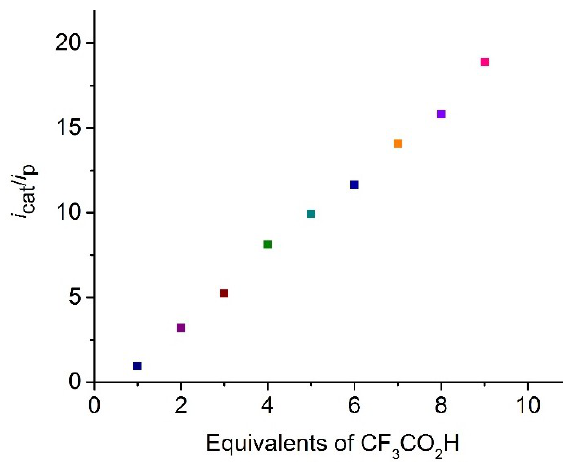
Figure 6. Dependence of i cat / i p on CF 3 CO 2 H concentration for [Fe 2 (CO) 4 (κ 2 -dppn)(μ-edt)] ( 3 ) at potentials of the first catalytic wave (in MeCN, 1 mM solution, 1–10 equivalents of CF 3 CO 2 H, supporting electrolyte [NBu 4 ][PF 6 ], scan rate 0.1 V∙s −1 , glassy carbon electrode).